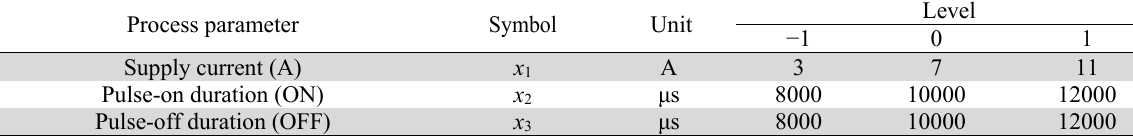
EDM process parameters and their levels (Majumder et al., 2014)